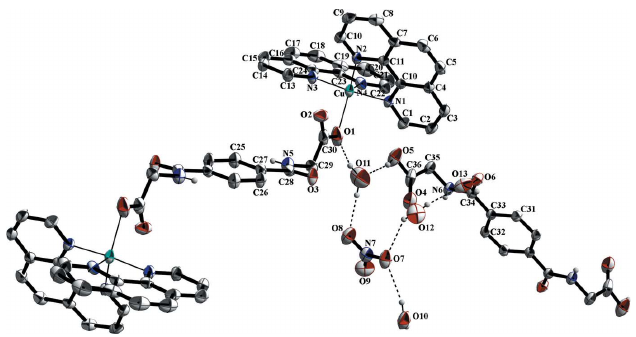
Figure 1 The structures of molecular entities in the title compound with atom labels and displacement ellipsoids of non-H atoms at the 40% probability level. Dashed lines indicate O—H (cid:2)(cid:2)(cid:2) O hydrogen bonds (see Table 1 for details). Unlabelled atoms are related to labelled ones by the symmetry operation (cid:4) x , (cid:4) y , (cid:4) z + 1 for the cationic complex and (cid:4) x , (cid:4) y + 2, (cid:4) z + 2 for the N , N 0 -(1,4-phenylenedicarbonyl)diglycine solvent